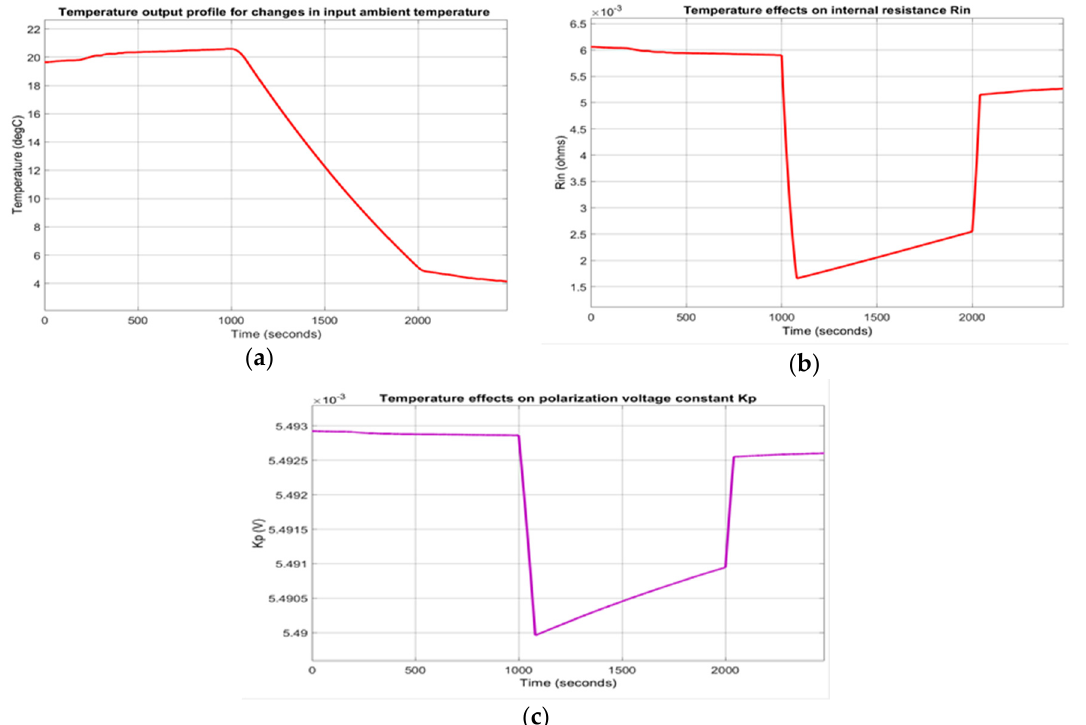
Figure 12. ( a ) The e ff ect of changes in ambient temperature, shown in Figure 10a, on output temperature profile; ( b ) The e ff ect of changes in ambient temperature on the internal resistance R in ( T ) ; ( c ) The e ff ect of changes in ambient temperature on the polarization constant K p ( T )